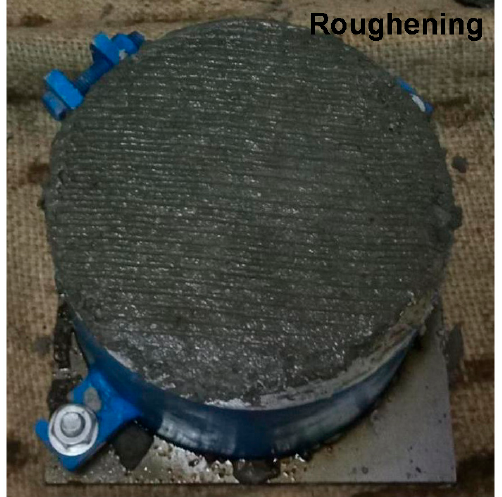
Figure 8. Roughening treatment.